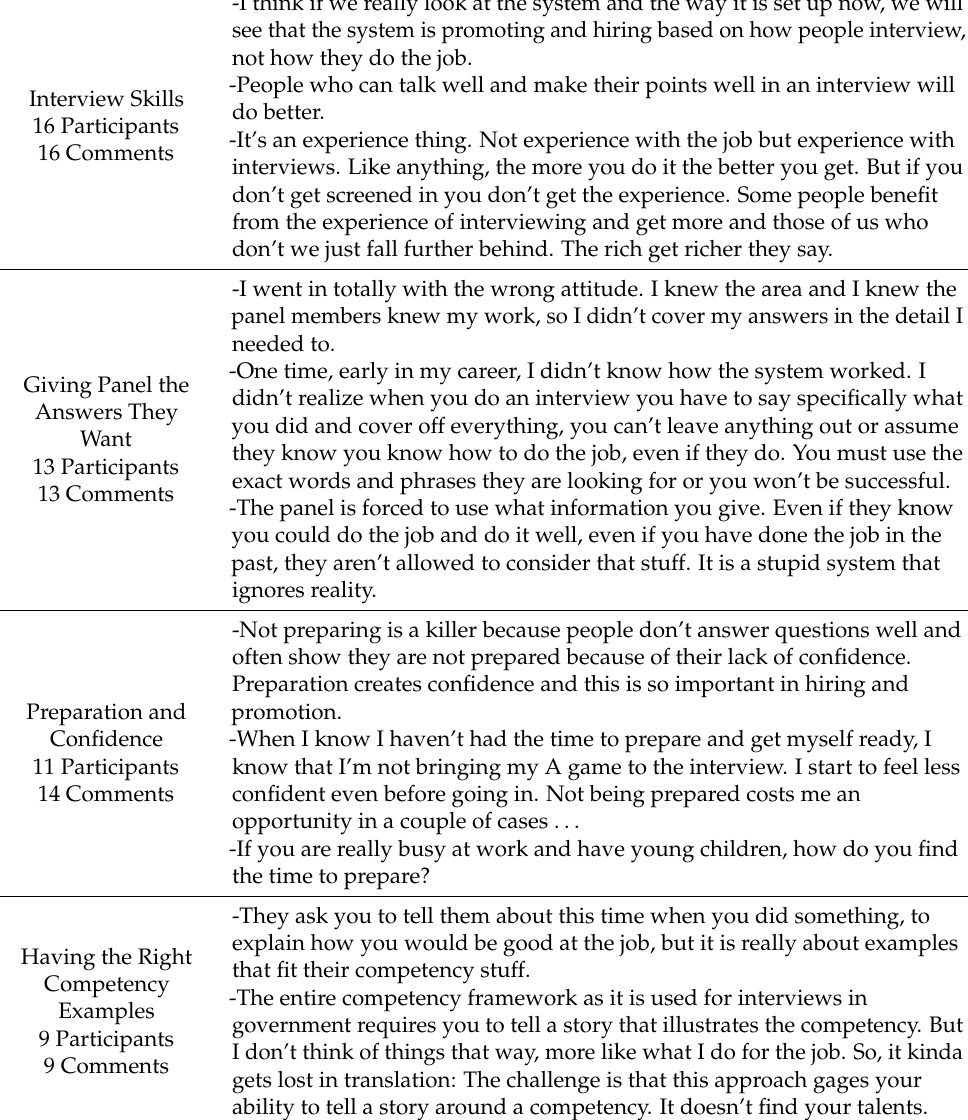
Table 2. Competition Skills (21 Study Participants contributing 52 comments) N = 67.